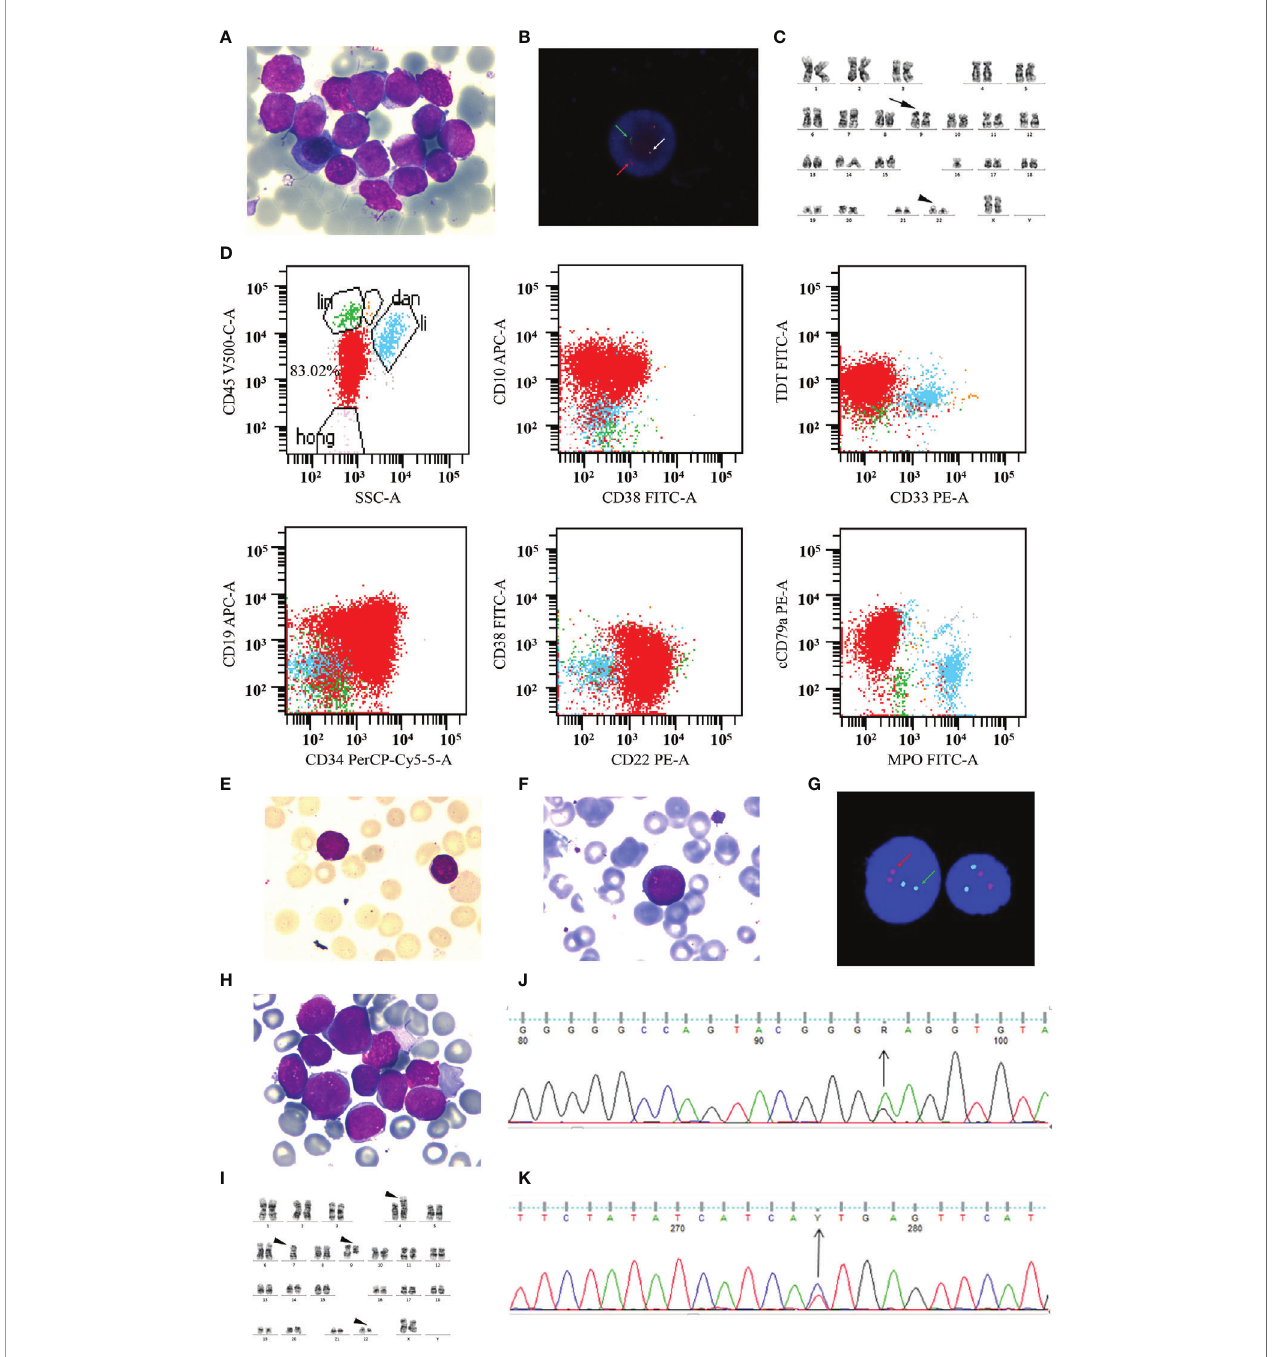
FIGURE 1 | The progression of a blast crisis. (A) A bone marrow (BM) aspiration revealed that lymphoid blasts account for 99.5% of all nucleated cells (Wright – Giemsa, ×1,000). (B) Interphase FISH analysis revealed the classical 1G1R2F translocation pattern in 39% of cells before treatment. The white arrows denote fusion